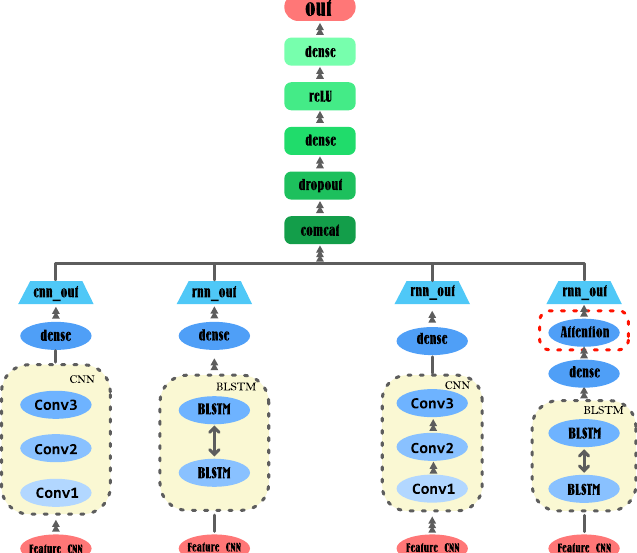
Figure 5. Comparison of DLCNN and improved DLCNN.